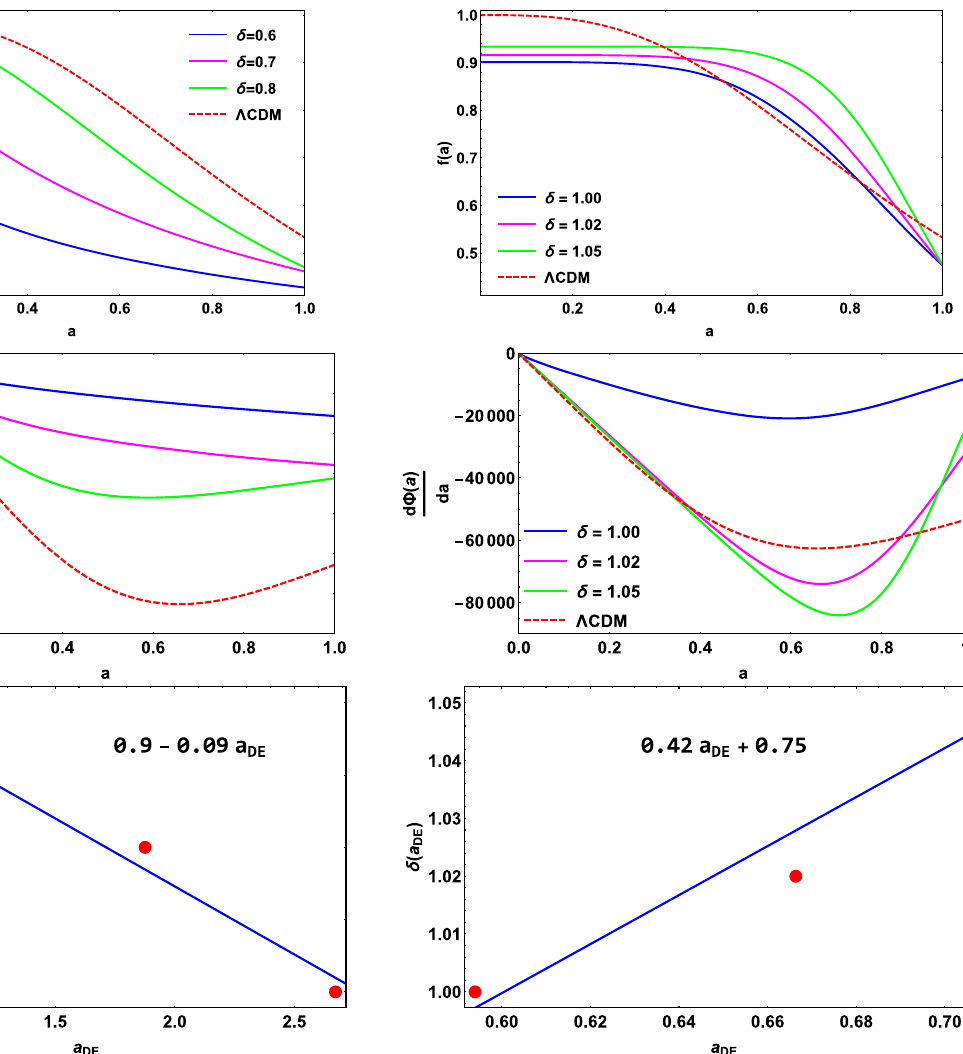
Fig. 3 Topleftpanelshowstheevolutionofgrowthrate f ( a ) ,topright panel shows the rate of change of configurational entropy ( d Φ( a ) the lower panel shows the best fit relation between the non-additivity parameter δ and the scale factor a DE at which d Φ( a ) The plots are drawn for m = 0 . 8 and n = 0 . 5